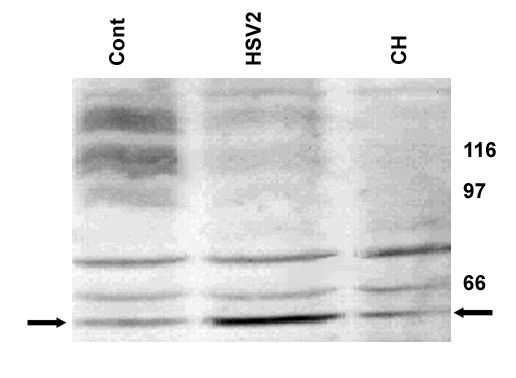
Effect of HSV2 infection on APP processing in SHSY5Y cells. SHSY5Y human neuroblastoma cells were either untreated (cont), infected with HSV2, or treated with cycloheximide (CH), then incubated for 9 h. Cell lysates were analysed by Western blotting as in Fig 1A. Arrows indicate the band intensified by HSV2 infection.